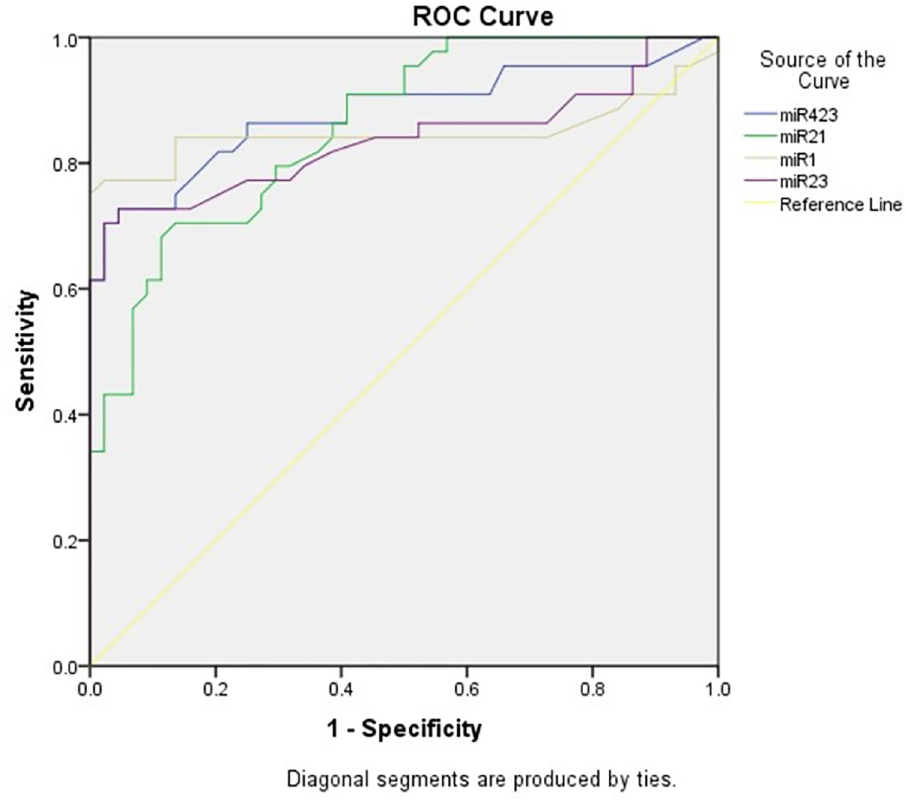
Fig 2. ROC curve plotted for four selected miRNAs for diagnosis of acute heart